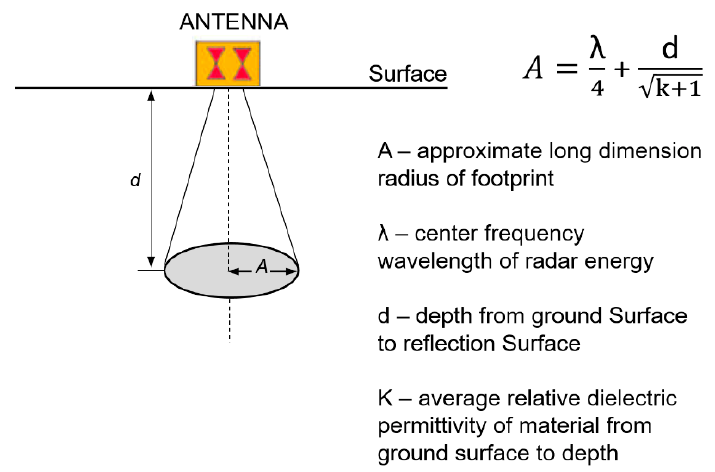
Figure 6. Simplified GPR antenna footprint (Fresnel zone) for bistatic dipole antennas.